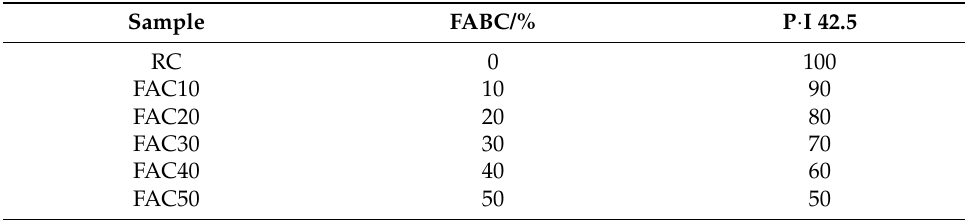
Table 2. Mix proportions of composite